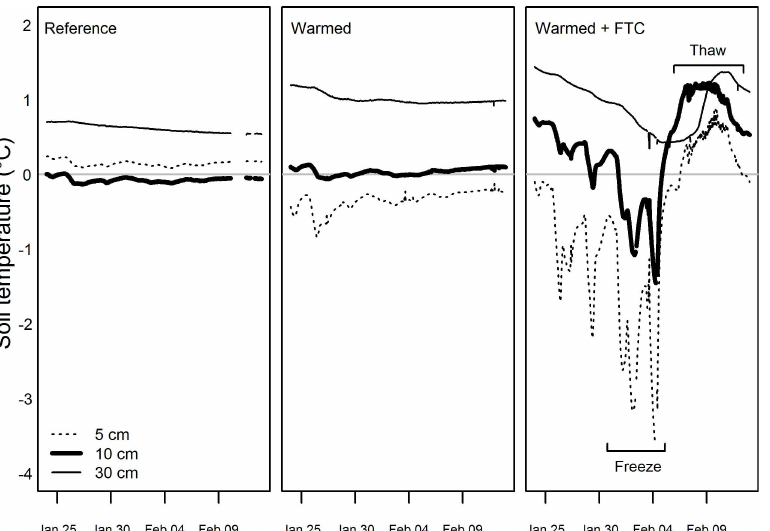
Fig 4. Soil temperatures averagedby treatment for each depth (5, 10, and 30 cm) during one freeze- thaw cycle in winter 2015 in the reference (left), warmed (center), and warmed + FTC treatment (right). We used soil temperatures at 10 cm depth (thickest line) to operationally define one soil FTC. Note that while the temperatures at 5 cm depth are higher than 10 cm depth in the reference plots, they are not significantly different from each other.